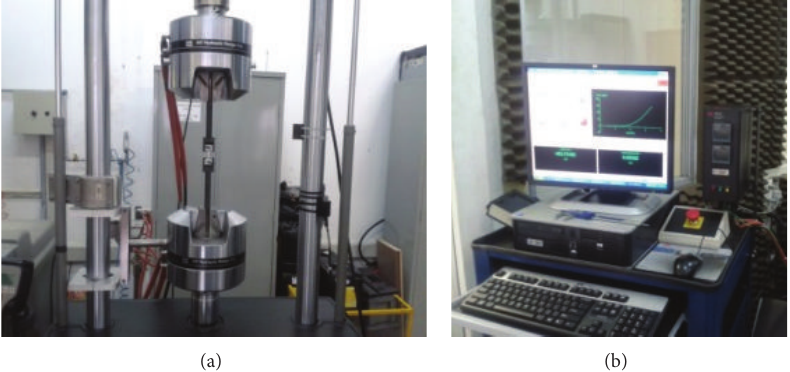
Figure 9: (a) MTS tensile test machine. (b) Data acquisition system.